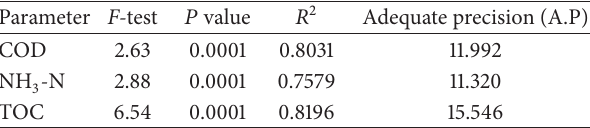
Table 2: ANOVA of the response parameters. Parameter F-